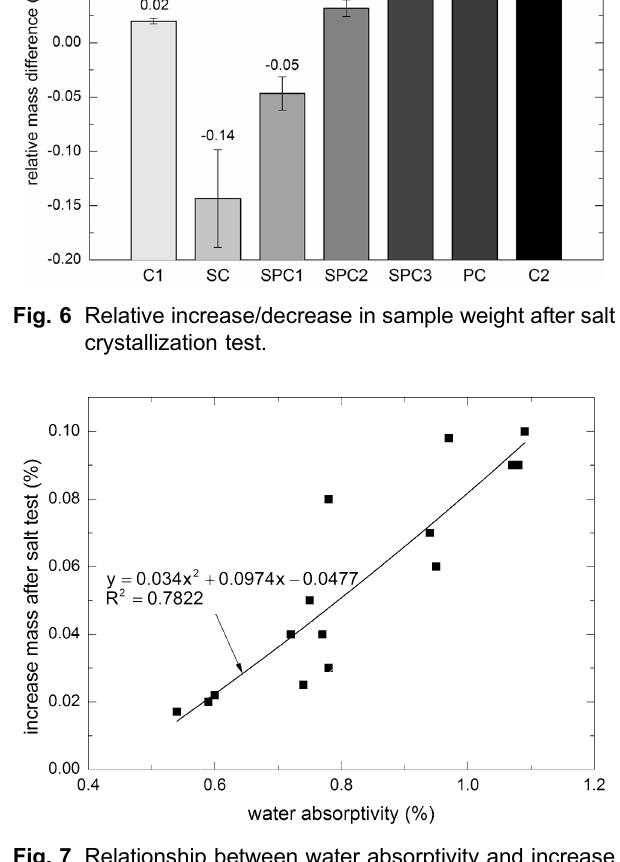
Fig. 7 Relationship between water absorptivity and increase in mass after salt crystallization test.